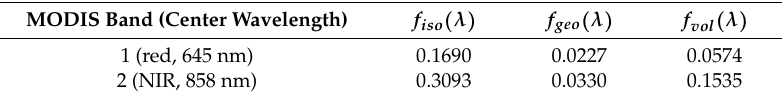
Table 1. Fixed global annual MODIS spectral BRDF model parameters for the MODIS red and NIR bands (reproduced from Table 5 of [16]) used in this study.